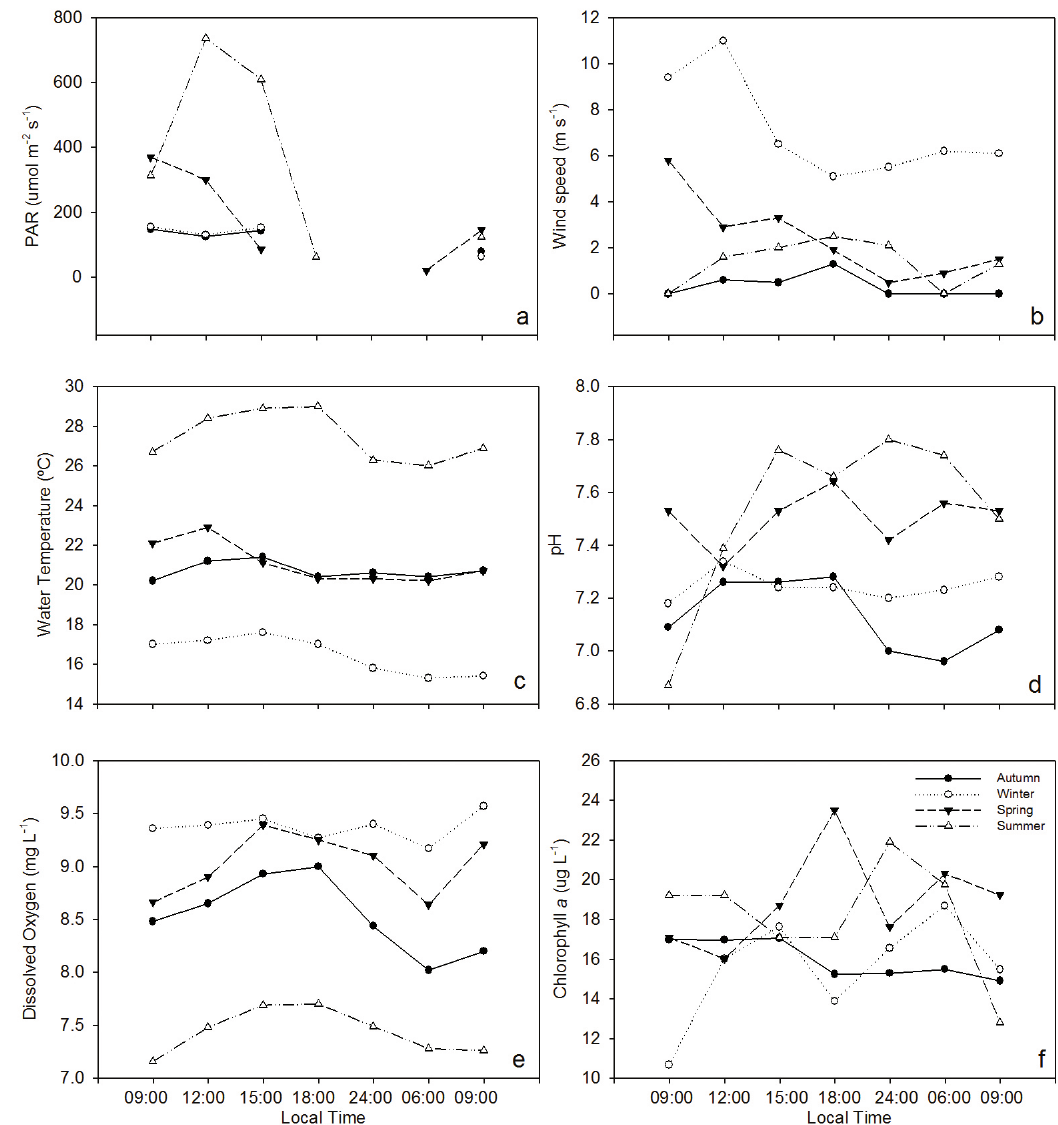
Figure 2. Diel and seasonal variation in environmental conditions in Peri Lake during the sampled period in autumn (May 23, 2010), winter (August 1, 2010), spring (September 30, 2010) and summer (January 13,